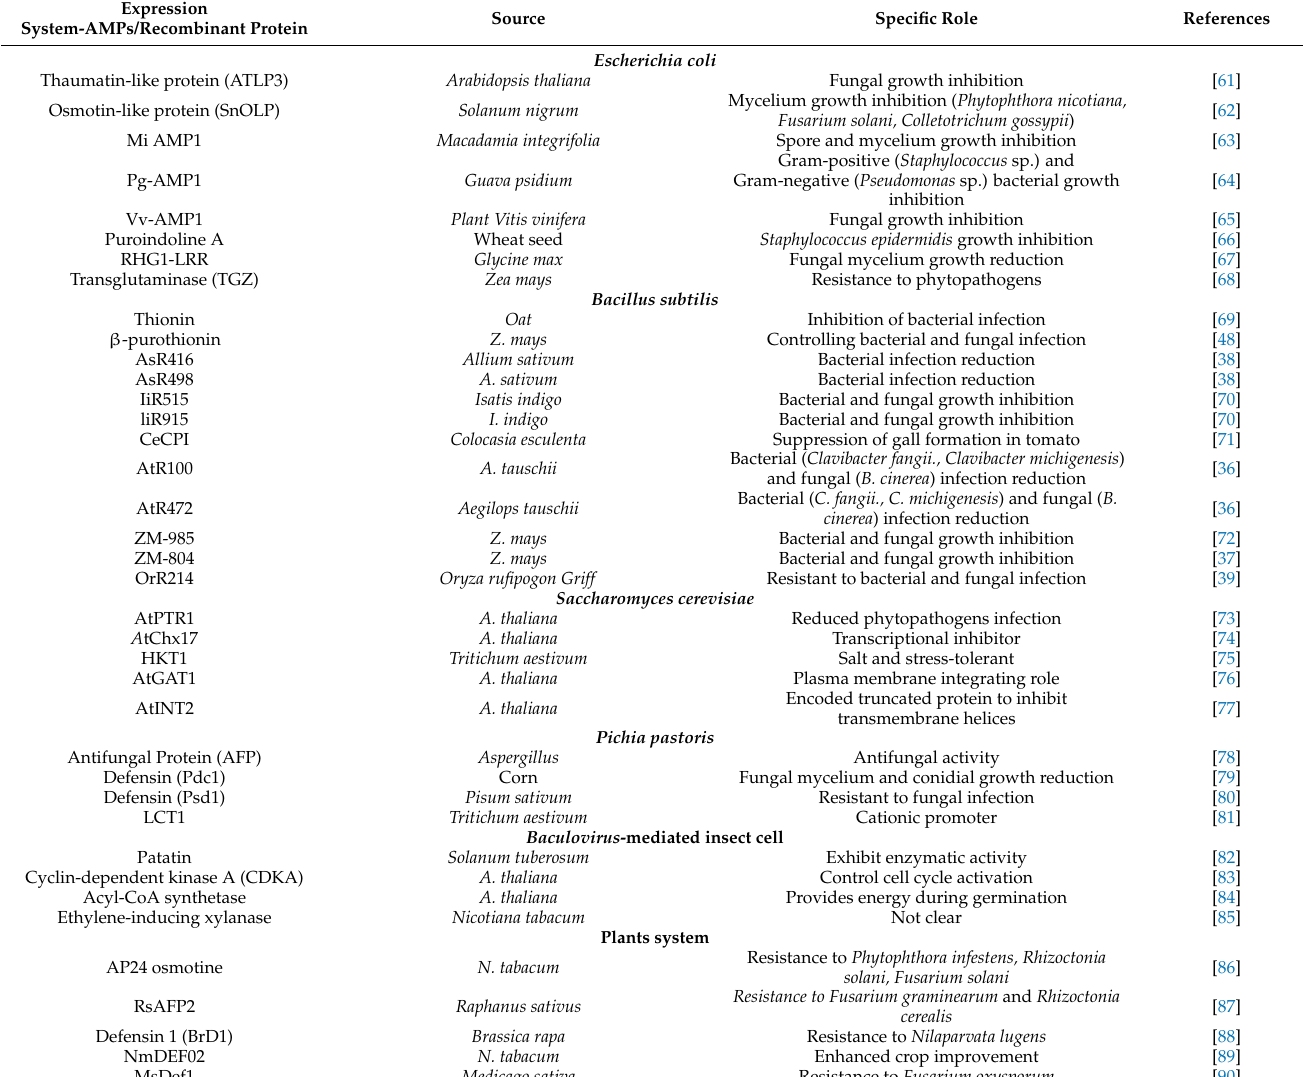
Table 1. List of AMPs/recombinant proteins produced by different expression